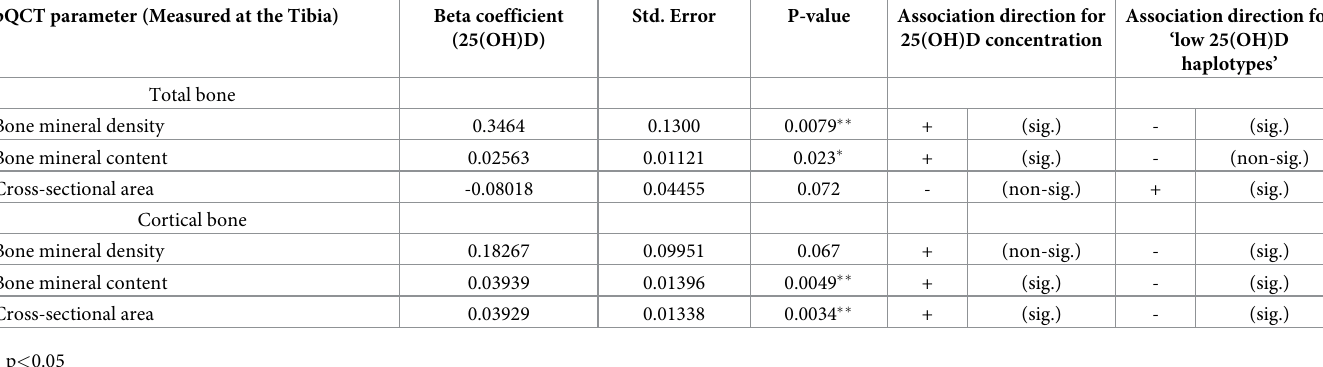
Table 2. Associations between serum 25(OH)D and pQCT measurements at 24 months. pQCT parameter (Measured at the Tibia)